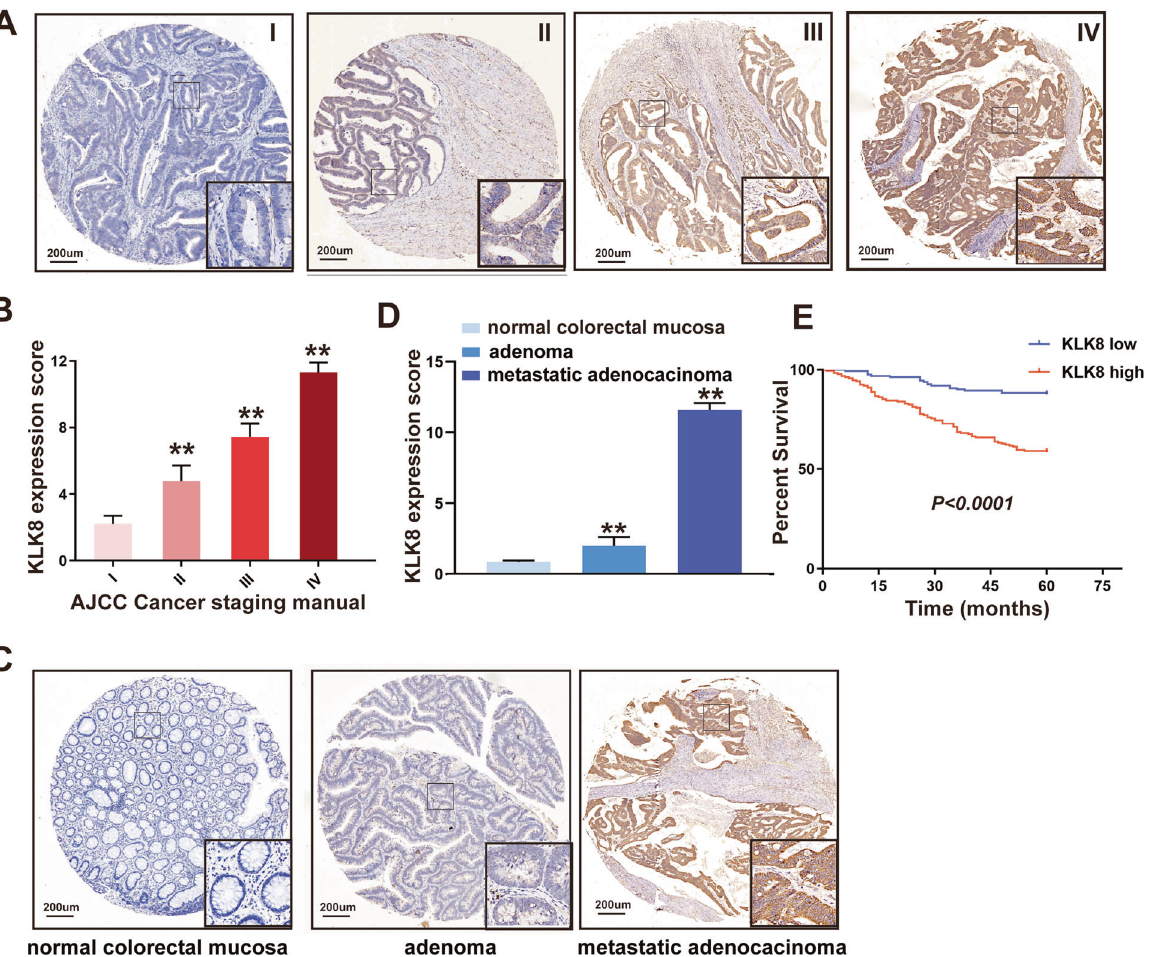
Fig. 2 Kallikrein-related peptidase 8 (KLK8) gene is highly expressed in colorectal cancer and correlates with poor prognosis. A KLK8 expression in colorectal cancer tissues at different stages, from I to IV based on AJCC Cancer Staging Manual, were measured using IHC. KLK8 expression scores were shown in ( B ). C KLK8 expression in normal colon tissue, adenoma and metastatic adenocarcinoma was measured using IHC. KLK8 expression scores were shown in ( D ). E Comparison of the percent of survival of patients with high-level KLK8 (KLK8-High) and low level KLK8 (KLK8-Low) expression using the Kaplan − Meier method ( n = 350). P < 0.0001. ** P < 0.01 versus normal